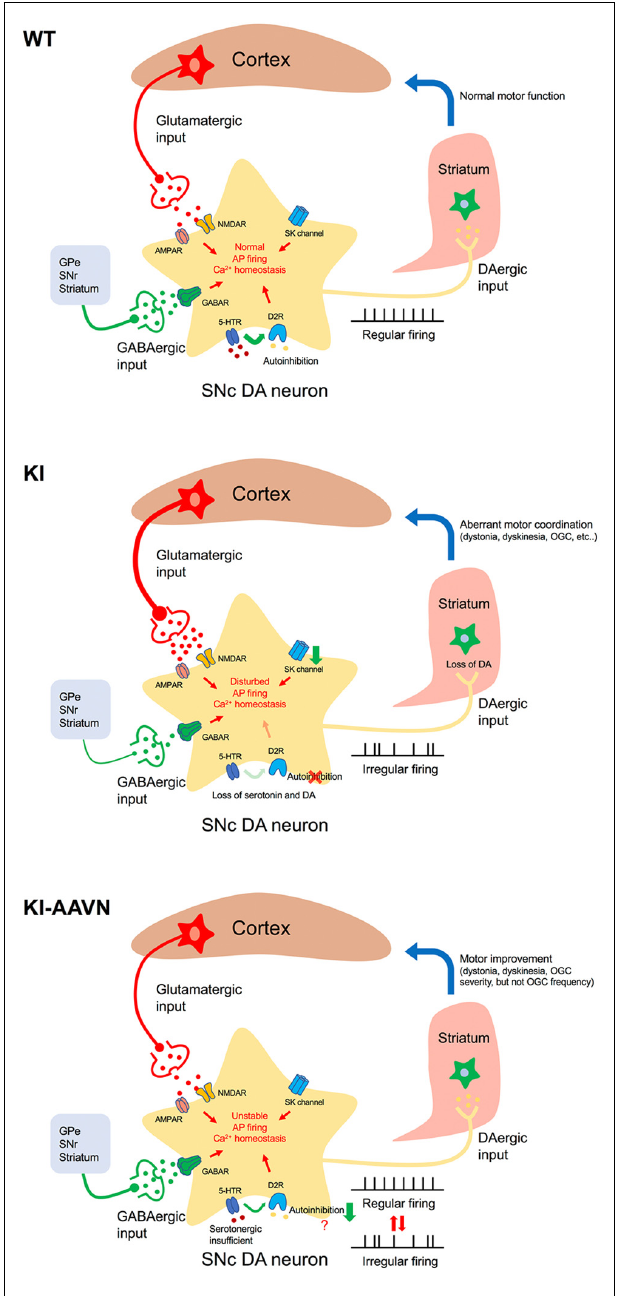
FIGURE 6 | Proposed mechanism of motor disturbances. Excitation/inhibition imbalance, loss of autoinhibition, and SK channels downregulation disturbs cytoplasmic Ca 2 + homeostasis in AADC deficiency SNc DA neurons (KI). Basal firing slows, the DA deficiency in the putamen worsens, and motor disturbances occur. Gene therapy treatment (KI-AAVN) reverses these electric abnormalities and relieves the symptoms of mice. However, the insufficient levels of serotonin may gradually, and repeatedly, influence the DA neurons and cause irregular firing patterns, which then lead to motor disturbance [rhythmic oculogyric crisis